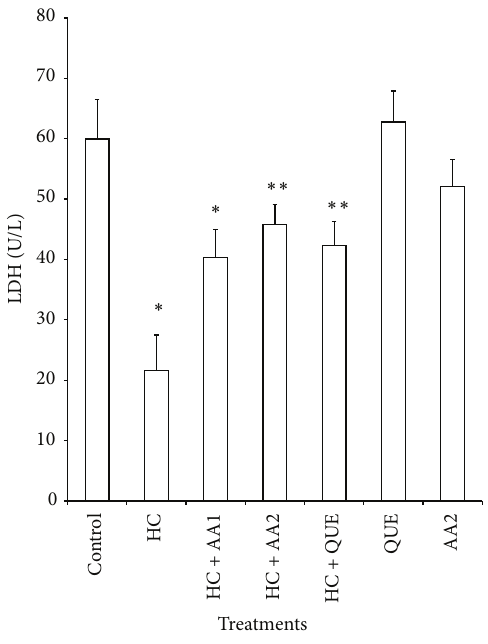
observed in this study as well as the elevation of HDL-C. LDL- C, another primary target of CVD risk reduction therapy [41].